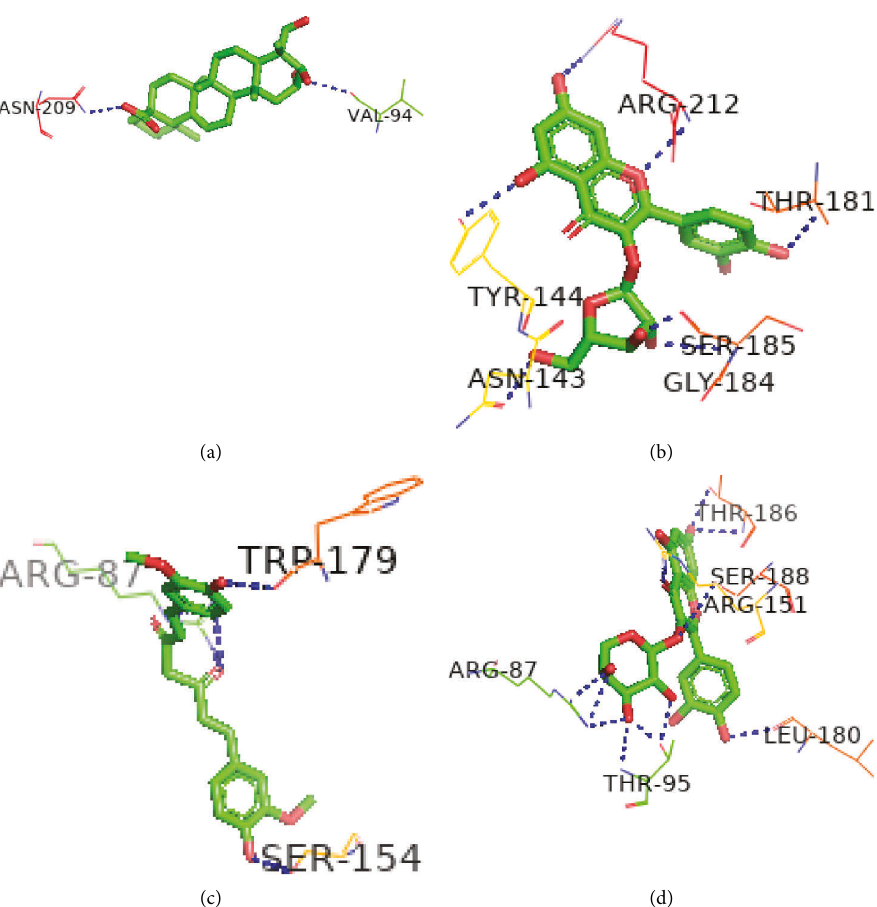
Figure 6: Polar binding sites of VP2 with (a) Asiatic acid, (b) avicularin, (c) curcumin, and (d)